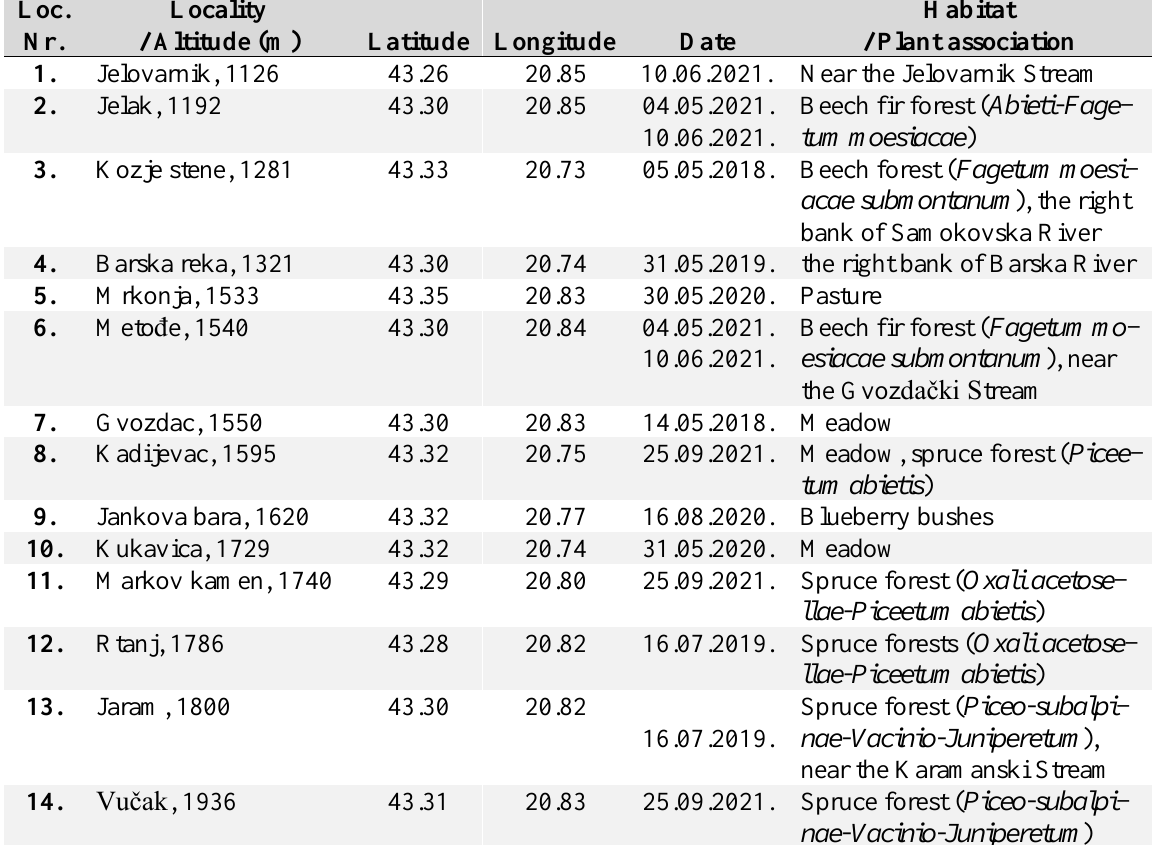
Table 1. List and description of studied localities in Kopaonik National Park.